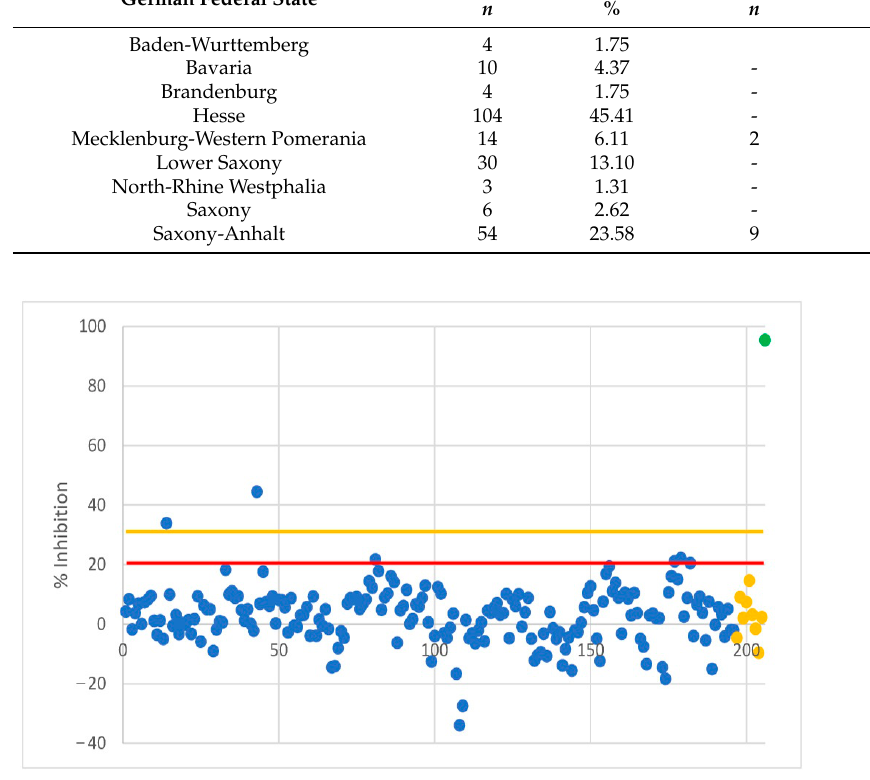
Figure 1. Results of surrogate virus neutralization test (sVNT). Two samples have been found to be positive during the first screening round. They were retested and found to be negative. Red line: Cut − off for reactive samples at 20% inhibition, orange line: Cut − off for positive samples at 30% inhibition. Blue: raccoons; yellow: raccoon dogs; green: mean of positive controls. Table 1. Origin of the tested samples. Samples were collected in eight German federal states with focus on Hesse and Saxony-Anhalt. All samples were tested for SARS-CoV-2 by RT-qPCR and sVNT.